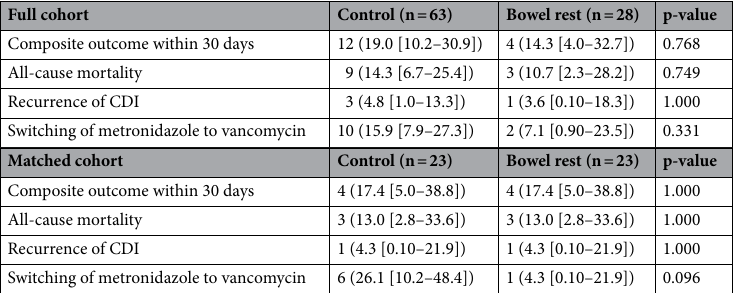
Full cohort Control (n = 63) Bowel rest (n = 28)